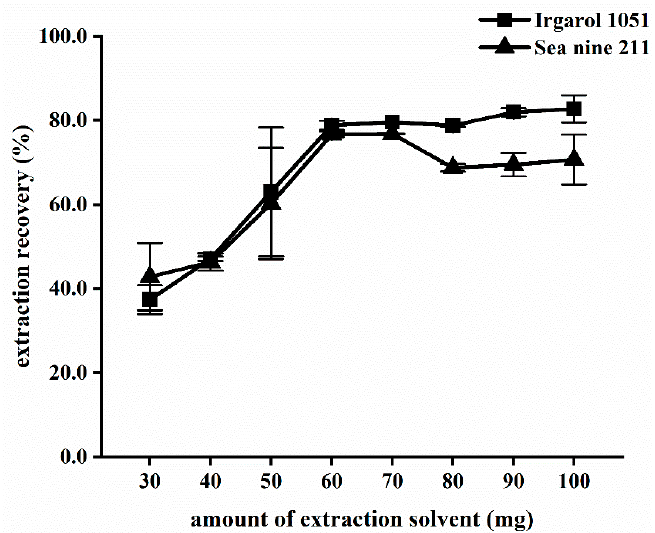
Figure 1. Effect of amount of [HMIm][PF6] on extraction recovery. Extraction conditions: water sample, 5.0 mL; disperser solvent, ethyl acetate 0.4 mL; NaCl 0% ( w / v ).; pH 6; and cooling temperature 20 °C.